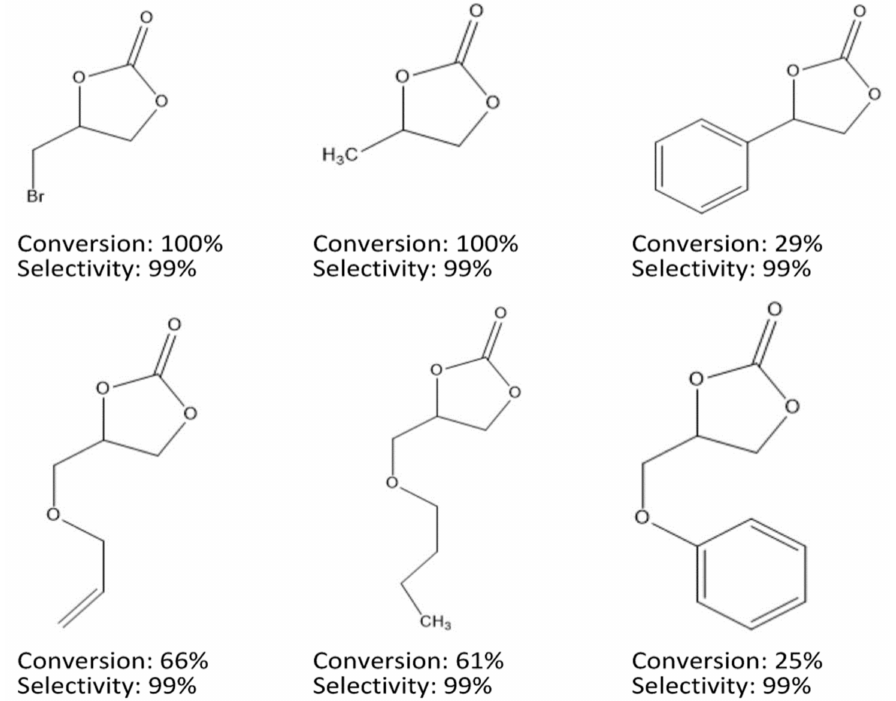
Figure 10. Organic carbonates obtained from MIL-101(Cr) catalyzed reaction. Reaction conditions: catalyst, 0.08 mmol; epoxide, 9.2 mmol; temperature, 35 ◦ C; pressure, 1.5 bar